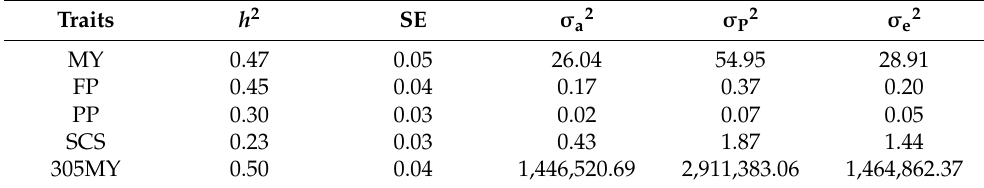
Table 5. The heritability of milk production traits 1 in Chinese Holsteins.